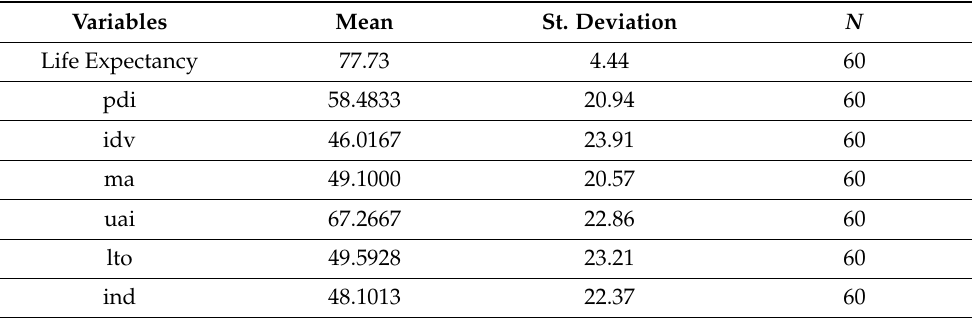
Table 1. Life Expectancy Model 1: Descriptive Statistics. Variables